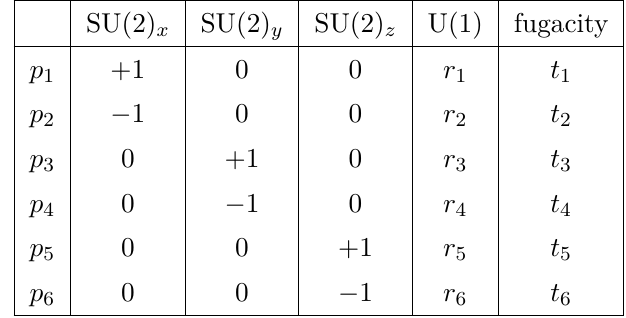
Table 47 . Global symmetry charges on the extremal brick matchings p i of Model